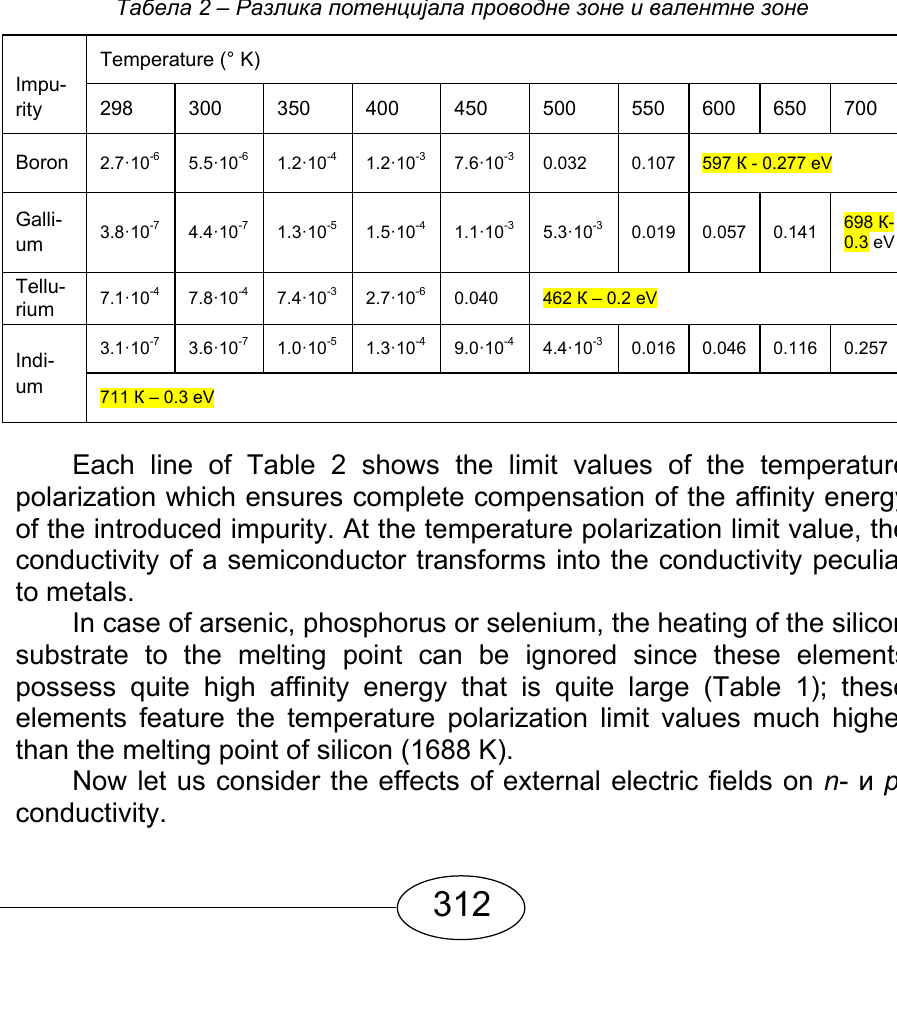
Table 2 – Potential difference between the conduction band and the valence band Таблица 2 – Разность потенциалов между валентной зоной и